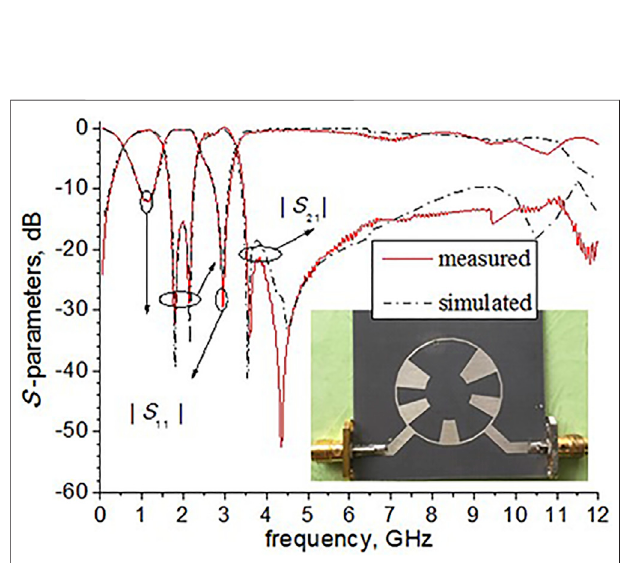
FIGURE 5 | Simulated and measured S-parameters with photograph